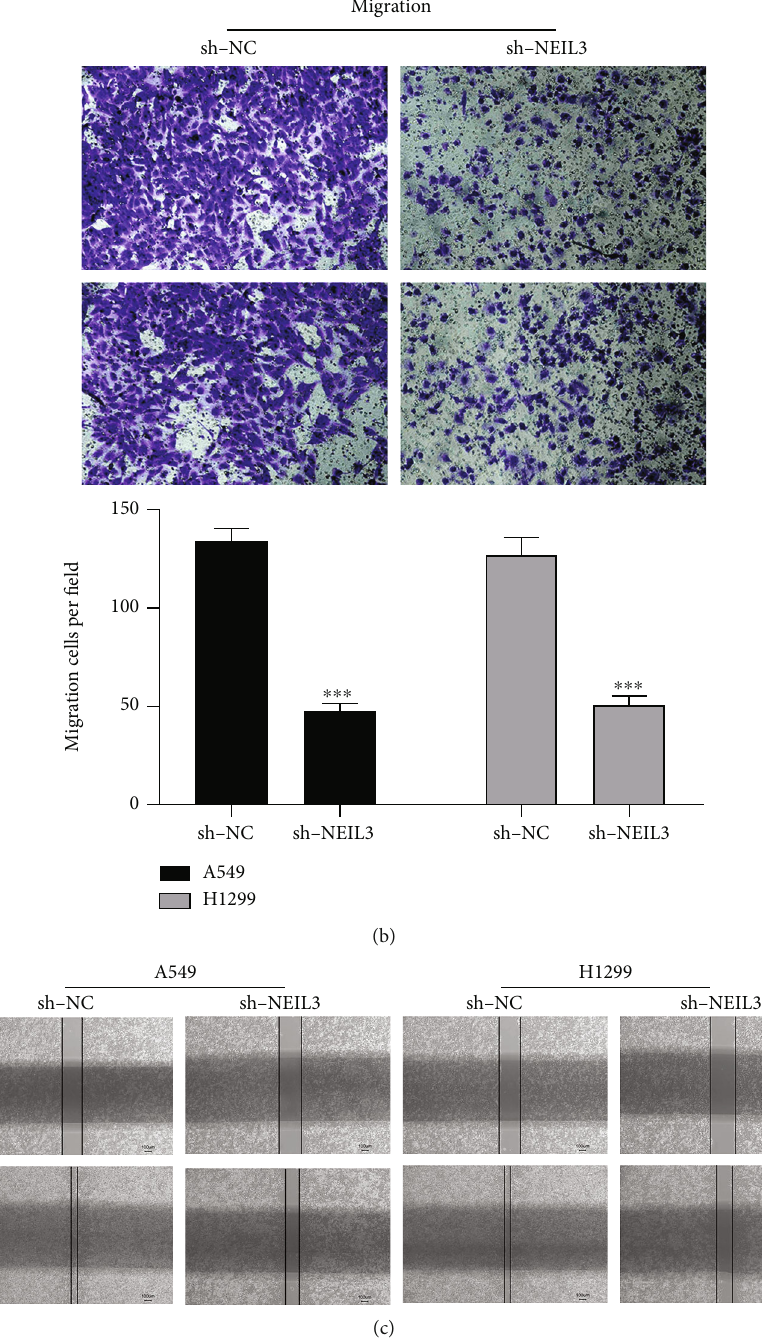
Figure 5: ENO2 facilitated lung cancer cell invasion and migration. Notes: (a, b) transwell assay was performed in control and NEIL3 knockdown cells; (c) wound healing assay was performed in control and NEIL3 knockdown